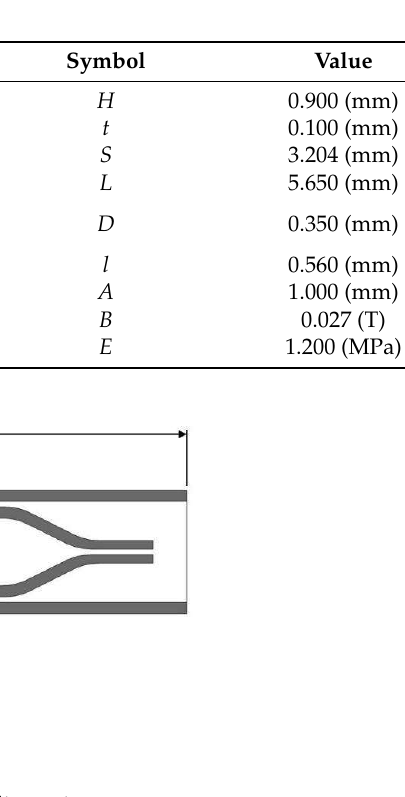
Figure 2. Duckbill valve model with its main components.